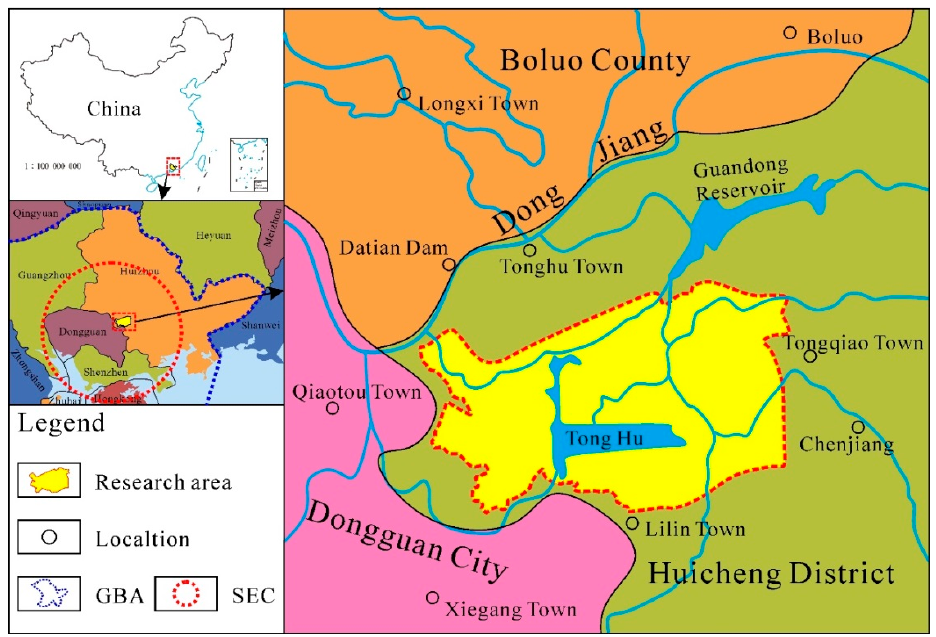
Figure 1. Location map of the study area.